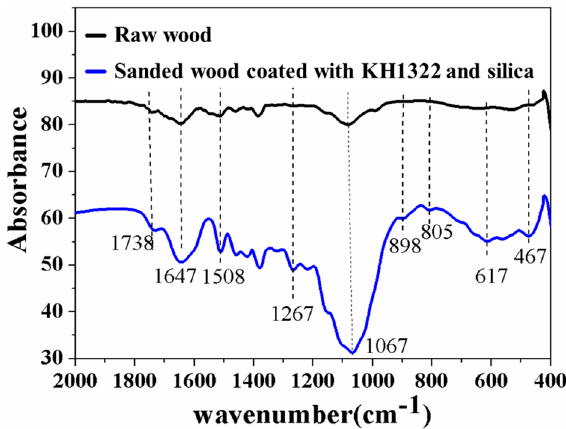
Figure 2. Comparison of Fourier transform infrared spectroscopy (FTIR) spectra between raw wood and sanded wood coated with KH1322 fluoroalkylsilane and